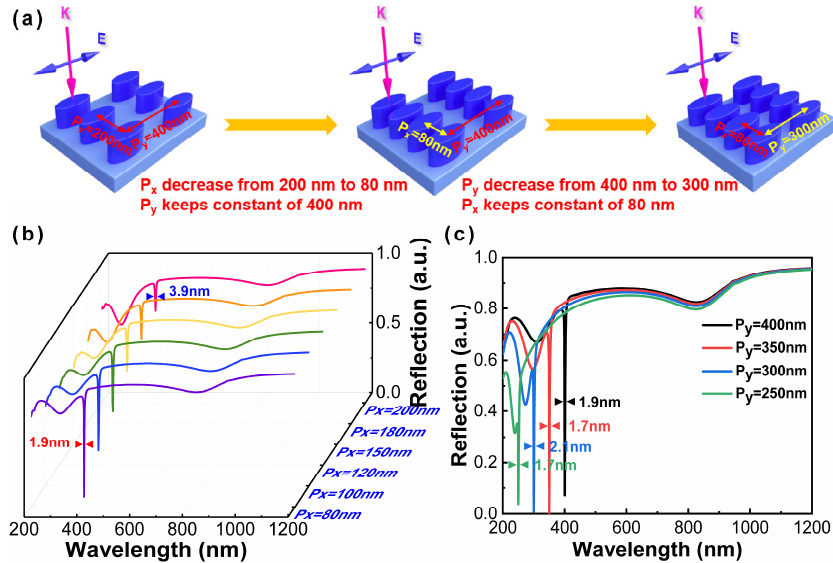
Figure 4. ( a ) Schematic illustration of periods of the Al nanoellipse metasurface. The corresponding reflectance spectra of the Al nanoellipse metasurface with varied ( b ) Px from 200 nm to 80 nm corresponding to the pink solid line to the purple solid line; ( c ) Py from 400 nm to 250 nm.